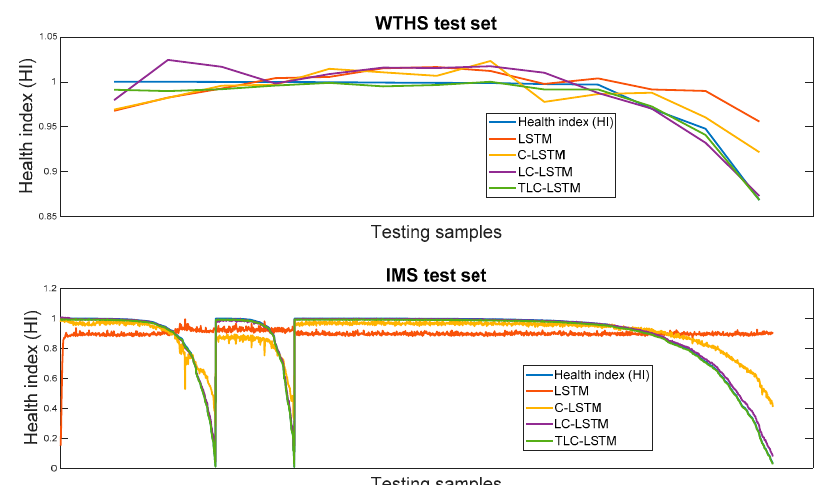
Figure 12. Health index (HI) curve fittings results.